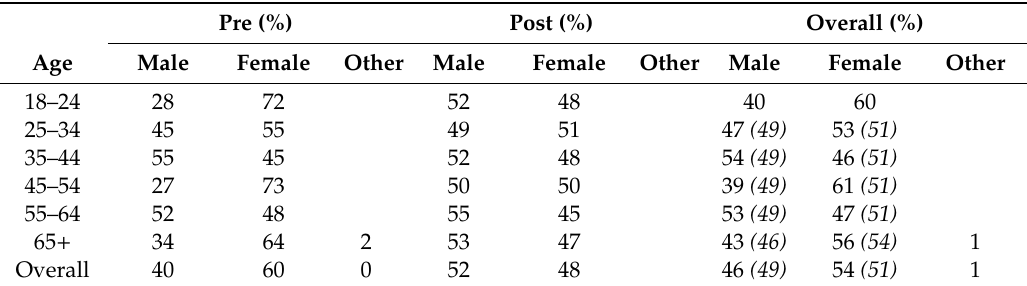
Table 2. Age / gender demographics (by percentage %) of CATI survey prior to (pre) and after (post) the 60 Minutes Programme (Census data in italics where